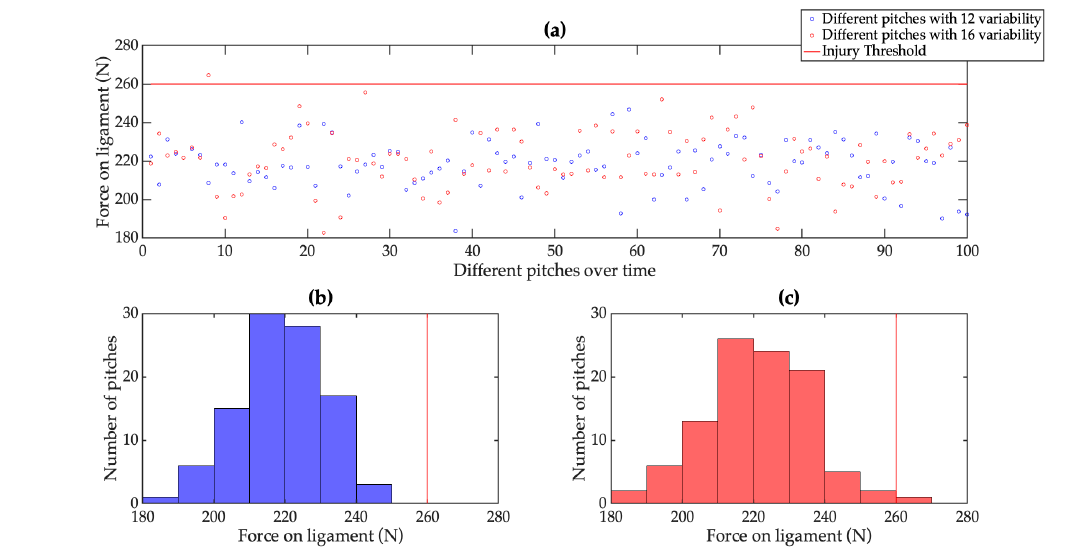
Figure 1. ( a ) The force on the ligament by different of pitches over time. Red dots: data from simulation 1 with a low variability; blue dots: data from simulation 2 with an increased variability. Red line: injury threshold. ( b ) The force distribution of simulation 1. ( c ) The force distribution of simulation 2 with an increased variability. Red vertical line in both lower panels: injury